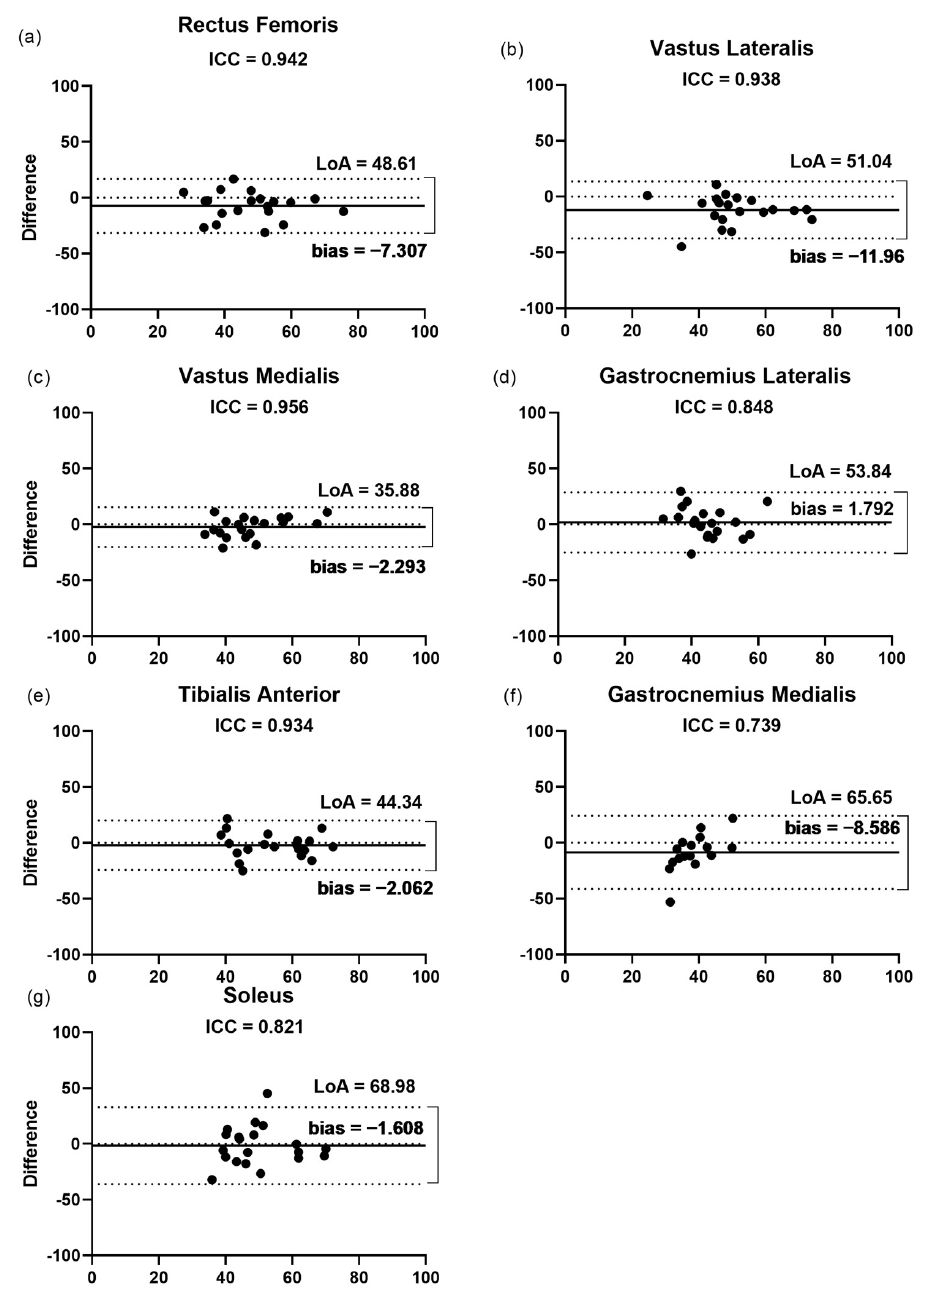
Figure 6. Bland–Altman plots displaying the differences (expressed as %) plotted against the average echogenicity recorded by the two raters for each muscle. ( a – g ) Inter-rater reliability of echogenicity measurement for ( a ) rectus femoris; ( b ) vastus lateralis; ( c ) vastus medialis; ( d ) gastrocnemius lateralis; ( e ) tibialis anterior; ( f ) gastrocnemius medialis; and ( g ) soleus. The lines show the zero, bias, and random error lines. Dashed lines represent the 95% limits of agreement (LoA). LoA, limits of